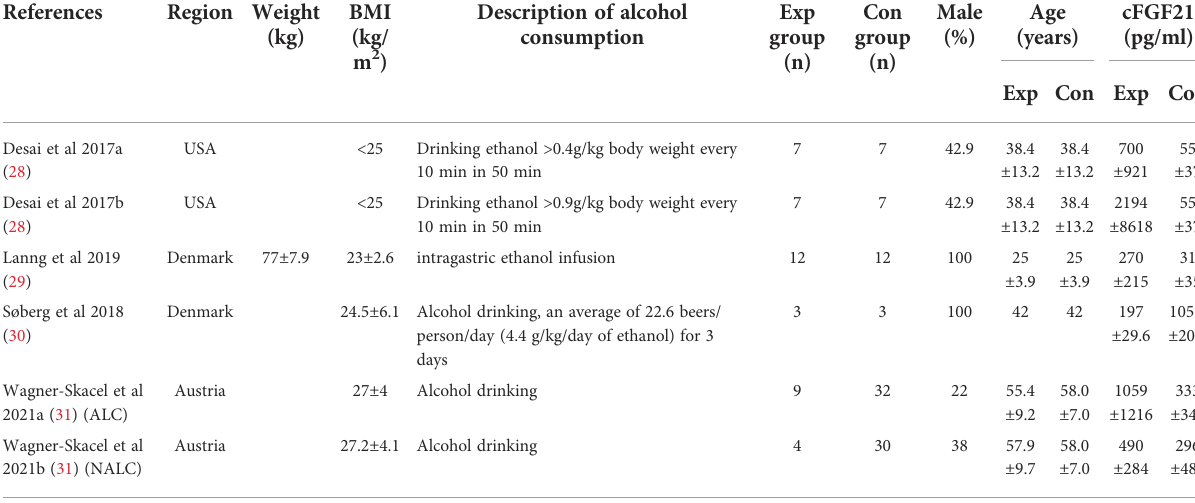
TABLE 3 Baseline characteristics of studies reported cFGF21 concentration in subjects with or without alcohol